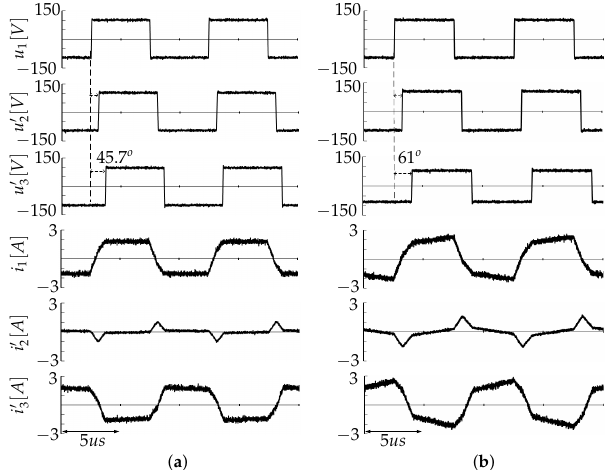
Figure 9. Experimental waveform of TAB converter in mode 1-2: ( a ) V 1 , V 2 , and V 3 are all 100%; ( b ) V 1 and V 2 are both 100%, V 3 is